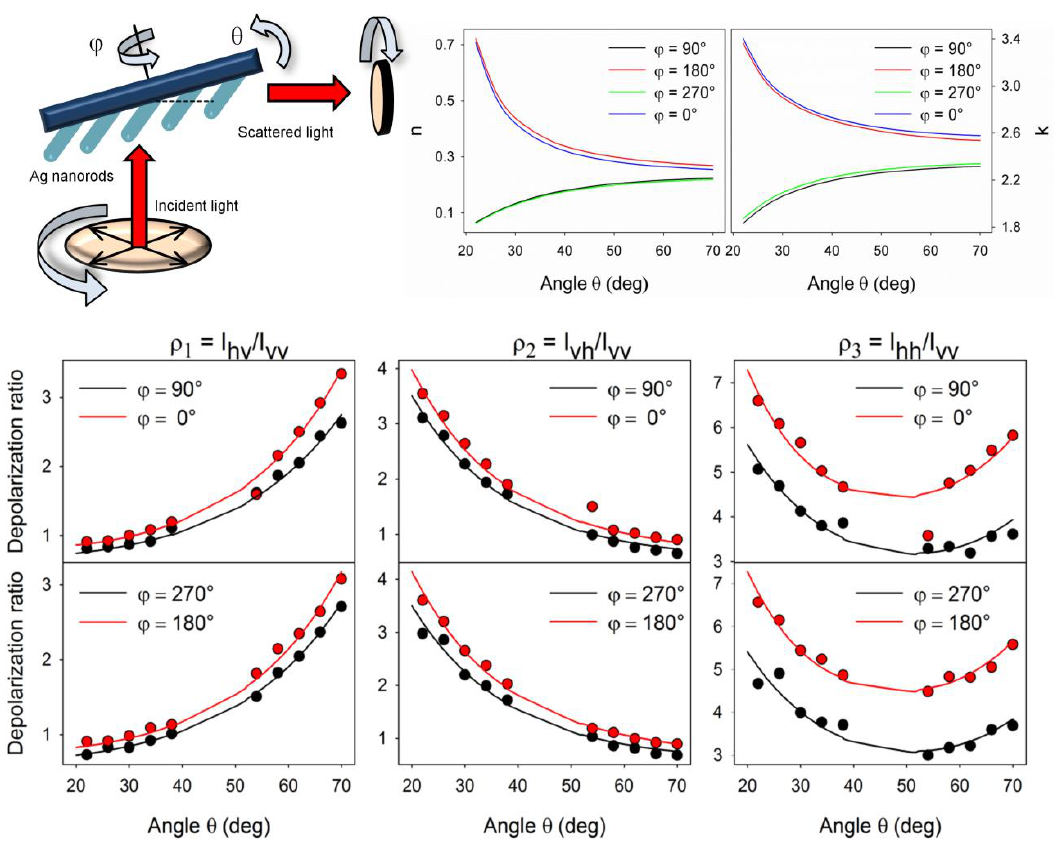
Figure 18. Upper left: Scheme of the experimental geometry used for polarization- and angular- resolved SERS on silver nanorod arrays using methylene blue (MB) as the probe molecule. Lower part: Depolarization ratio profiles for the 1628-cm − 1 MB band for different angular arrangements (colour points) and their fit by the surface-selection rules with pseudo-refractive indices obtained from ellipsometry measurements (lines). Excitation wavelength was 532 nm. Upper right: Real and imaginary part of pseudo-refractive index 𝑛̃ = 𝑛 + 𝑖𝑘 of silver NR arrays and their variation with both angles as measured by standard ellipsometry [112].